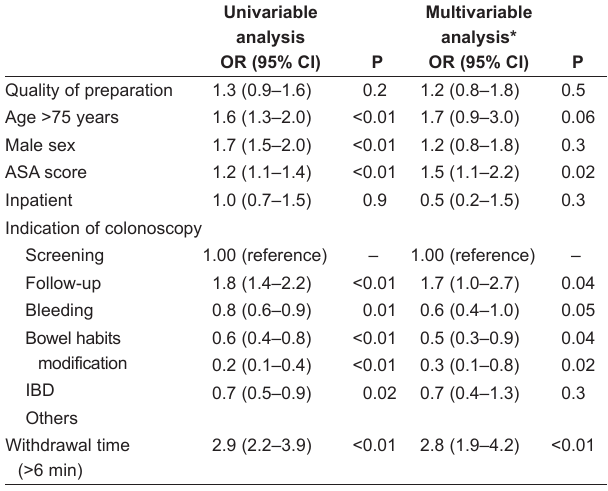
TAble 4 Independent predictors of inadequate bowel preparation